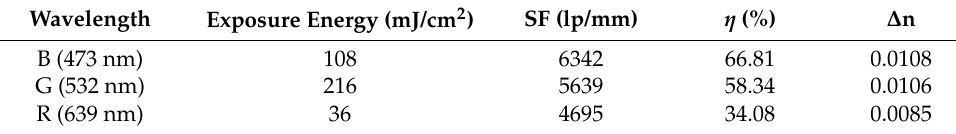
Table 1. 3D volume holography related parameters in the simultaneous exposure